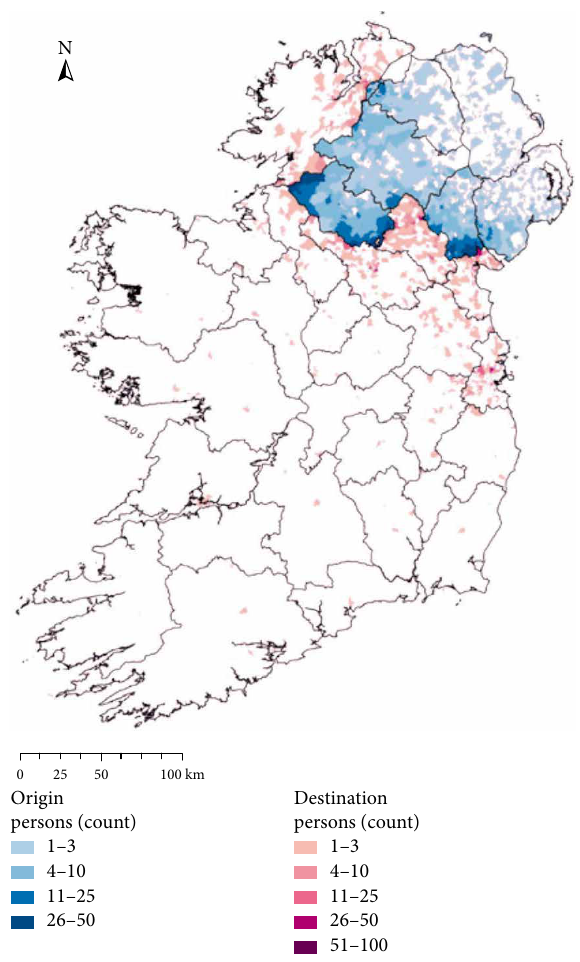
Figure 3: Cross‐border commuters from Northern Ireland to Ireland